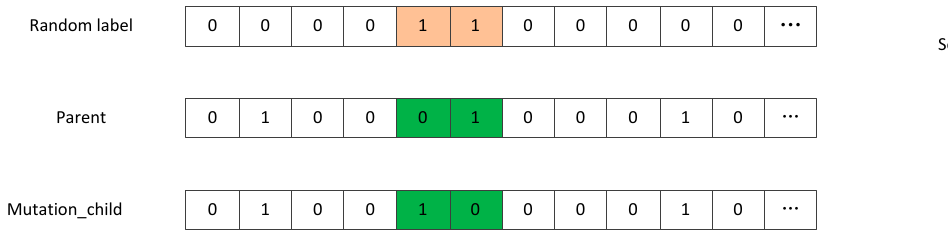
Figure 5. Operation of mutation.